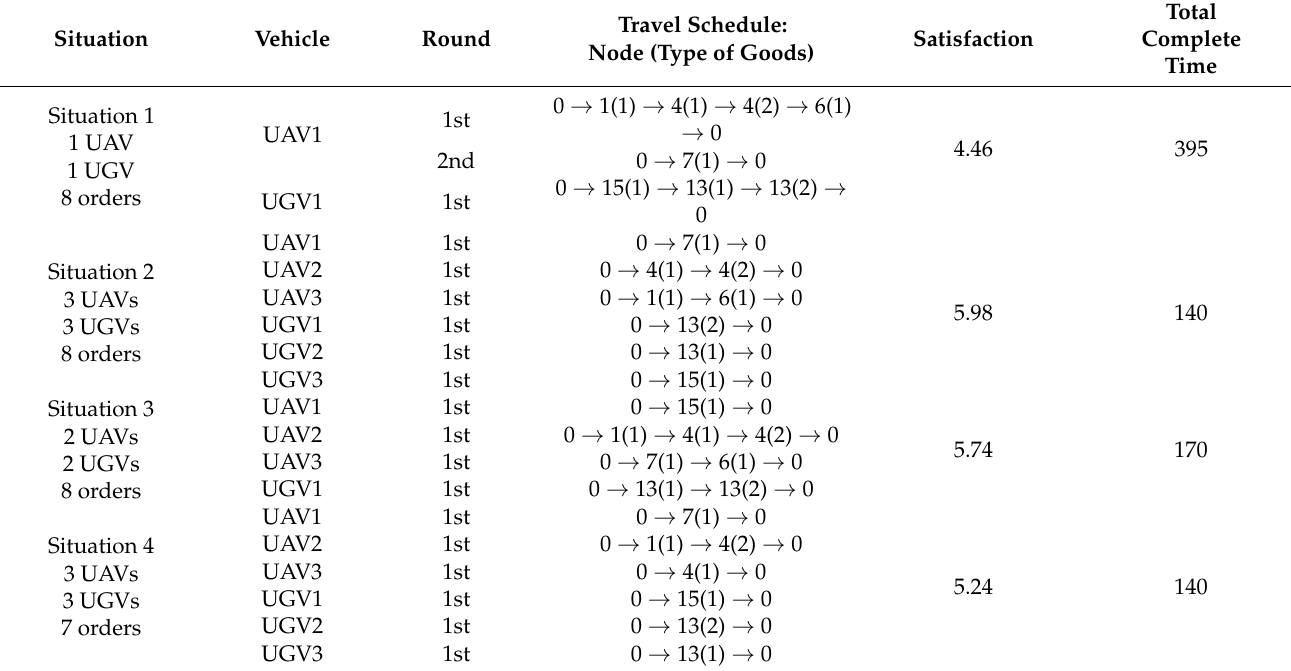
Table 4. The result of small size problem (Case 2).